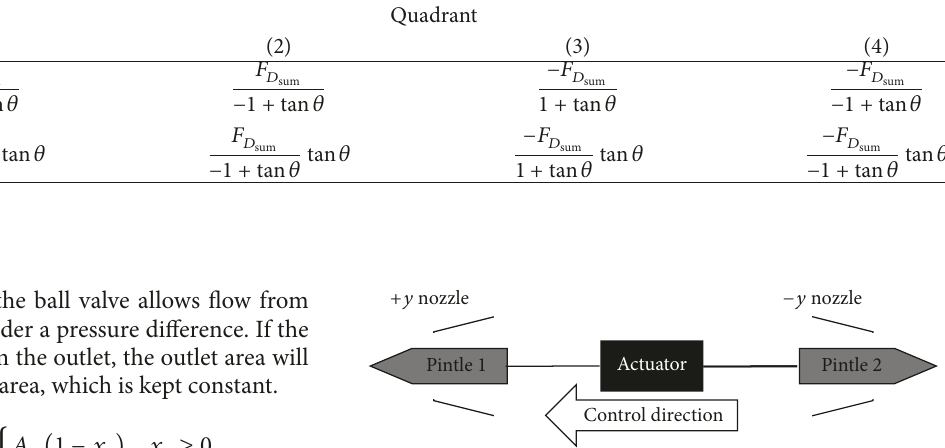
Table 1: Maximum force available based on saturation limit [2].